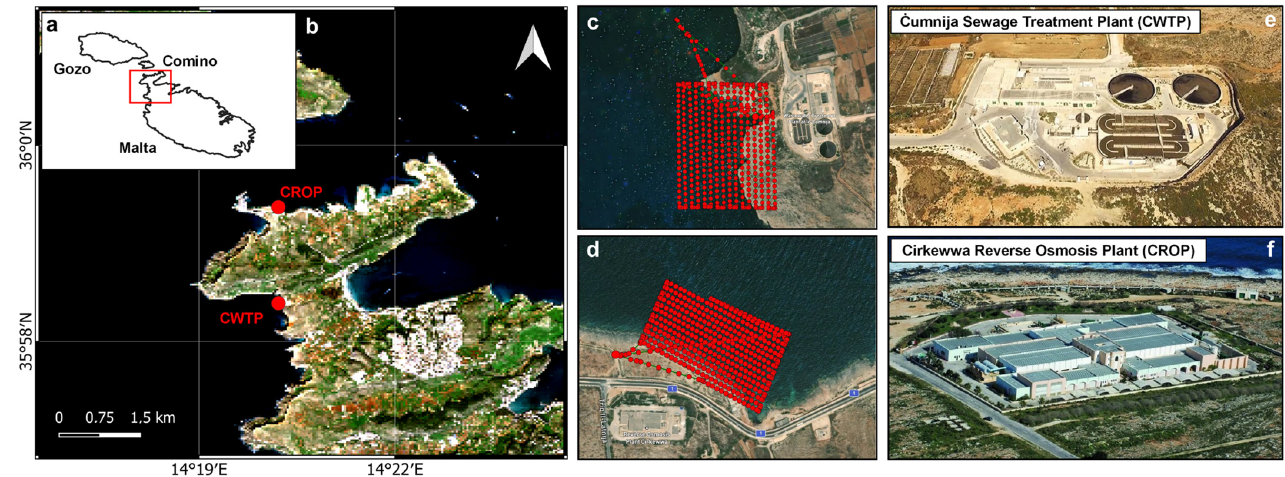
Figure 1. ( a ) Map showing the three islands that constitute the Maltese Islands archipelago: Malta, Gozo and Comino. ( b ) Zoom made on the Sentinel-2 image that shows the northeast coast of the island of Malta, where they are located: ( c ) flight plan at the Ċ umnija Sewage Treatment Plant (CSTP); ( d ) flight plan at the Cirkewwa Reverse Osmosis Plant (CROP); and ( e , f ) real images of CSTP and CROP, respectively.